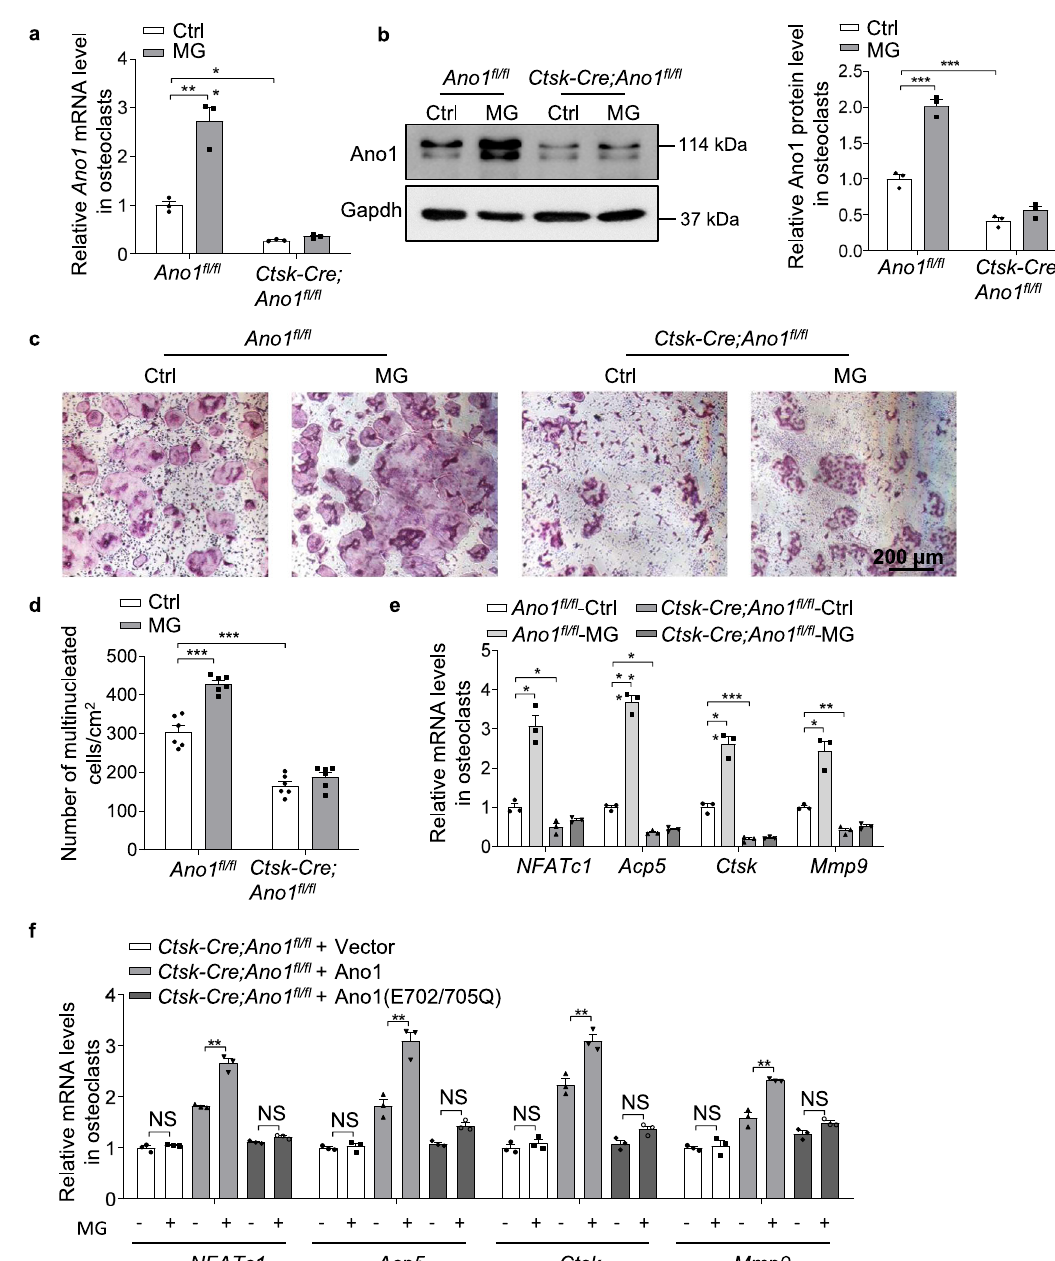
and Ctsk-Cre;Ano1 fl / fl osteoclasts after treatment with Ctrl or MG for 2 days. ( n = 3 independent experiments). b Western blot analysis of Ano1 protein